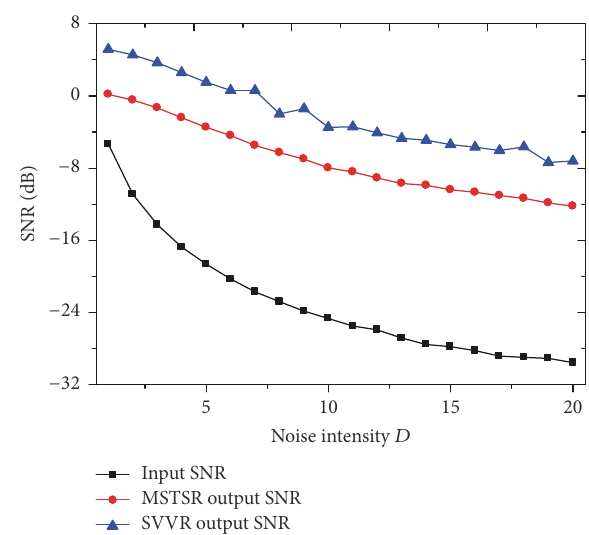
Figure 7: Experimental test